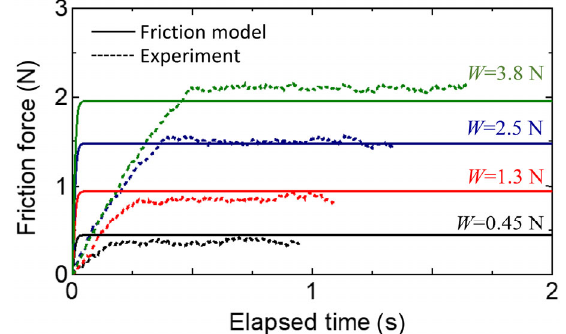
Fig. 11 Comparison of friction force vs. sliding displacement between the proposed model and experiment. The sliding velocity (driving speed of the PMMA plate) is 0.1 mm/s, and roughness of the rubber specimen R a = 2.11 μ m.